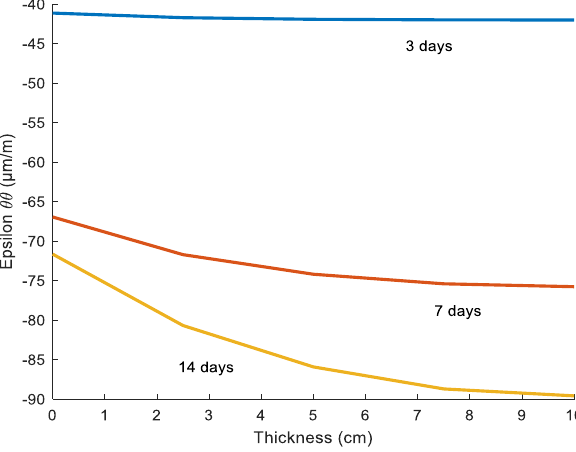
Figure 17: Hoop strain distribution along the thickness.